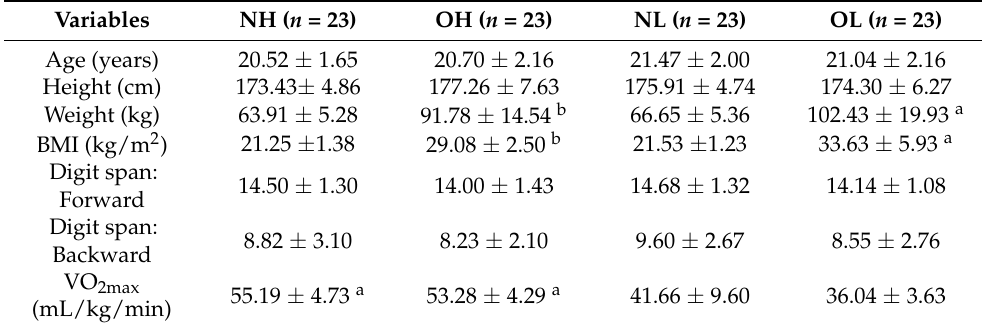
Table 1. Demographic and cardiorespiratory fitness for participants (means ± SD).